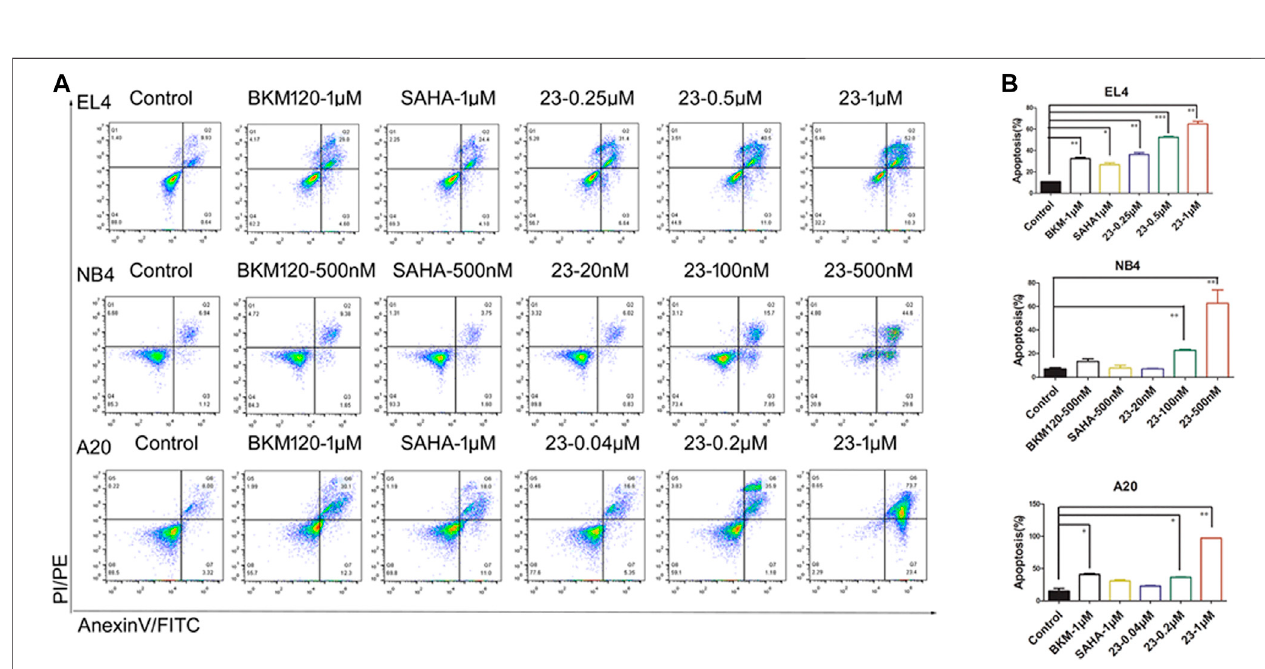
FIGURE 3 | Cell apoptosis induced by compound 23 ( 23 ). EL4, NB4, and A20 cells were treated by the indicated concentration of compound 23 , SAHA , and BKM120 for 24 h. Cells incubated in DMSO were used for comparison. (A) Representative histograms of Annexin V-FITC vs propidium iodide (PI)-PE staining results of fl ow cytometry. (B) Percentages of apoptotic cells (including early and late apoptotic cells) analyzed by fl ow cytometry (* p < 0.05, ** p < 0.01, *** p < 0.001 vs. Control).